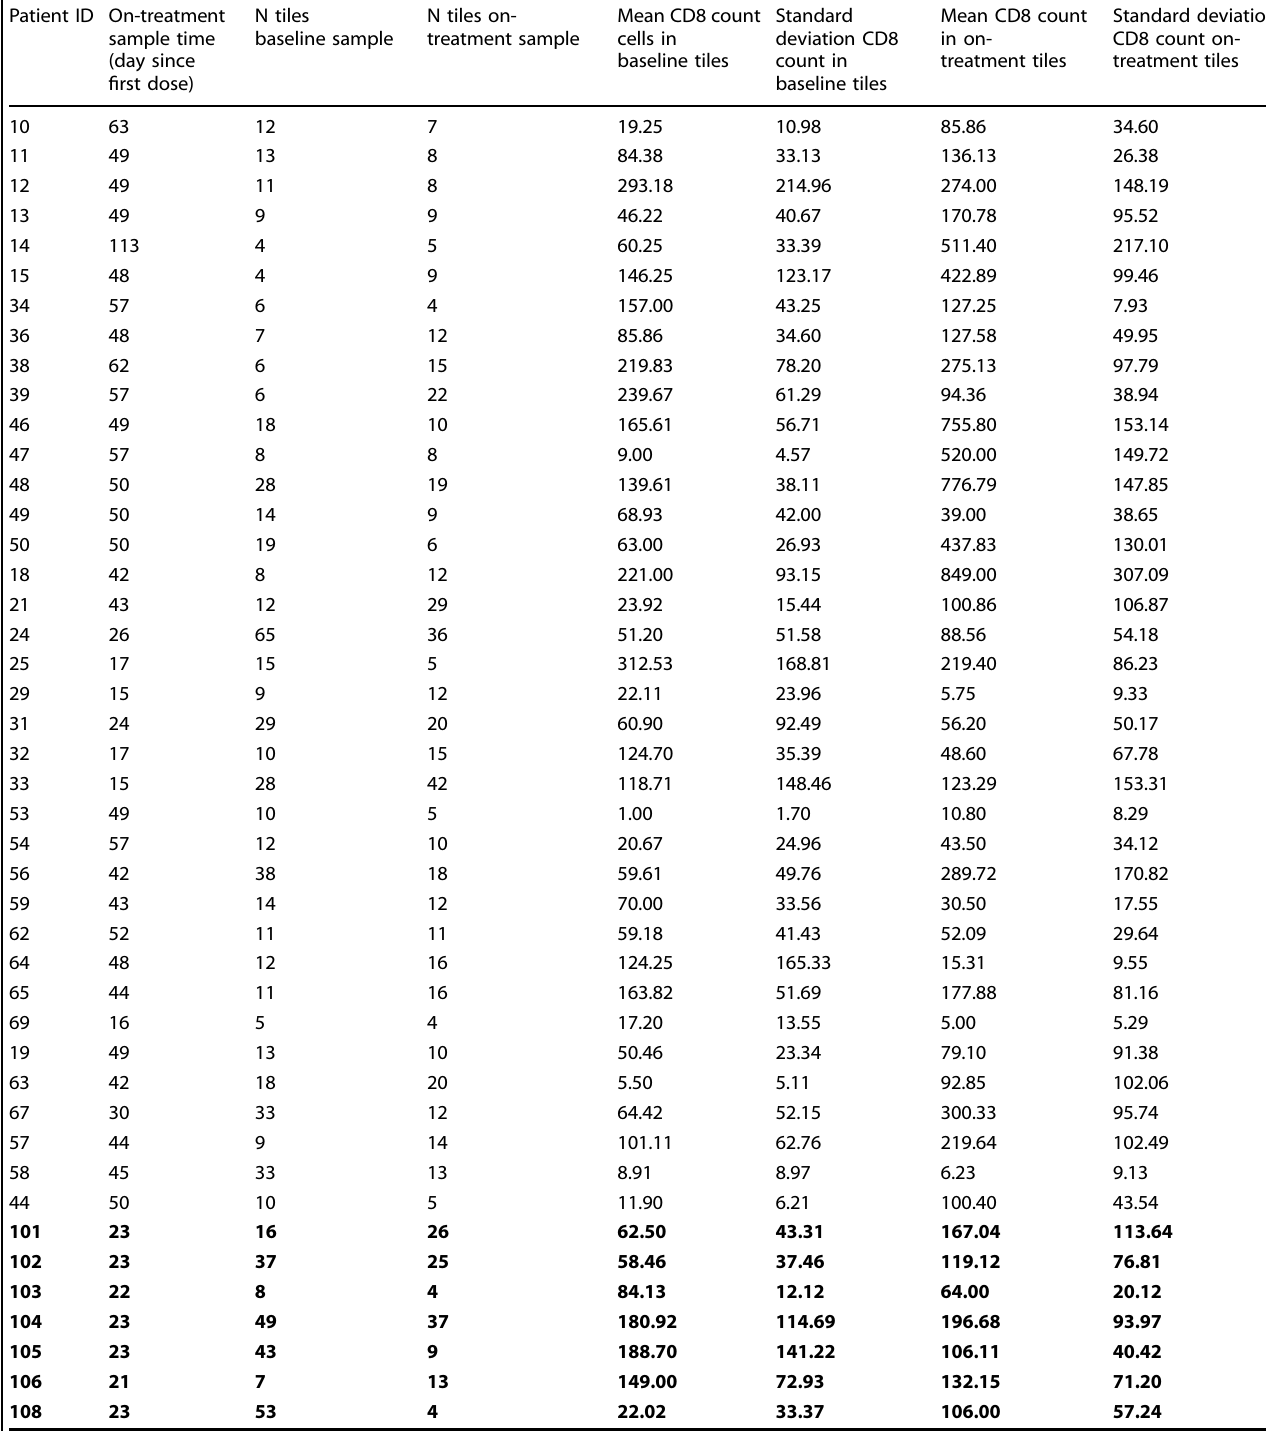
Table 1. Patient and sample information for patients in the training set and test set. Patient ID On-treatment sample